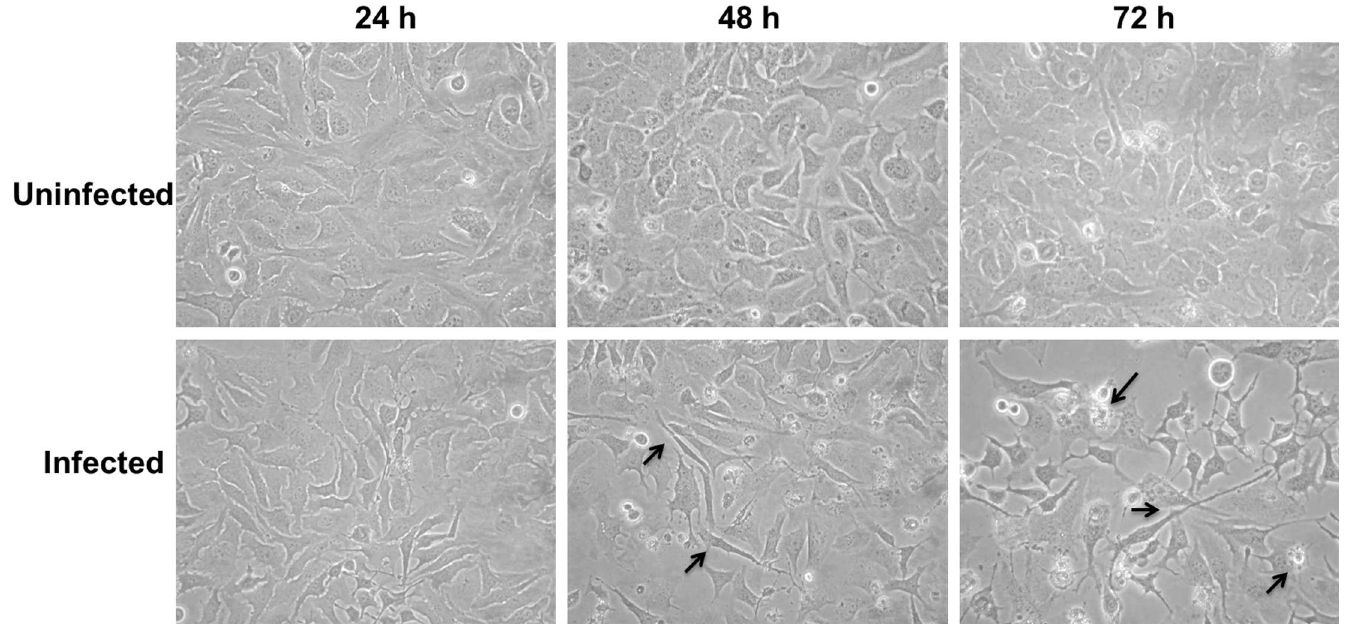
Fig 2. Phase contrast microscopic images showing the morphological changes in M . agalactiae -infected cells. Images were taken at 24, 48 and 72 h p.i. at 10x magnification. Pointed arrows show the profoundcell elongation and membrane blebbingin infected HeLa